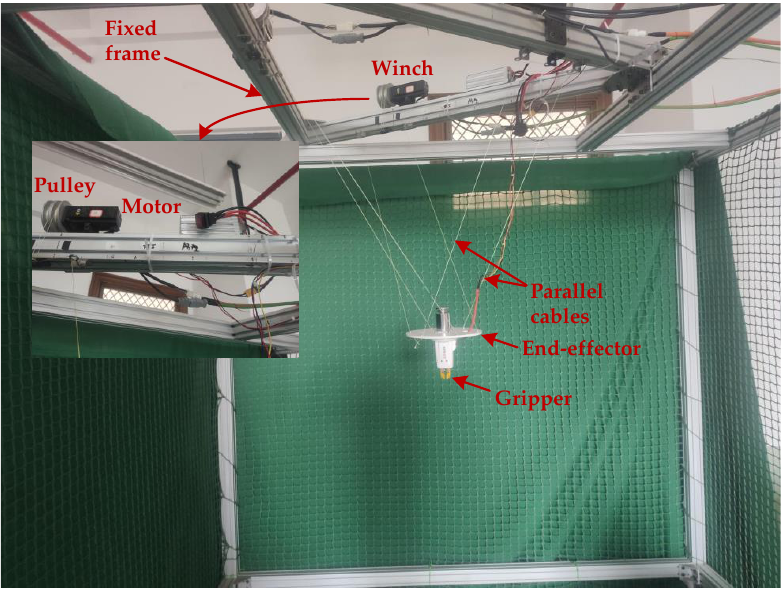
Figure 13. The six-cable CSPR prototype used for the launch motion tests.